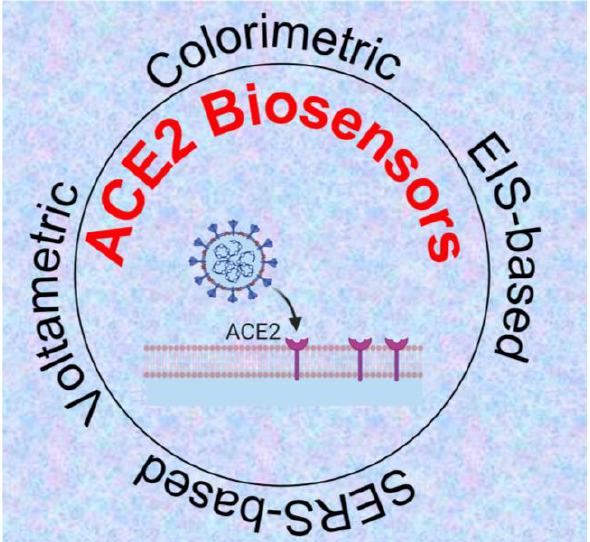
Figure 4. ACE2-based biosensing systems for detection of SARS-CoV-2 [51 – 54] Created with Bio-